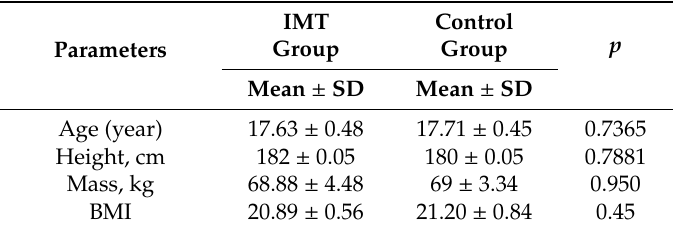
Table 2. Physical characteristics of young soccer players.